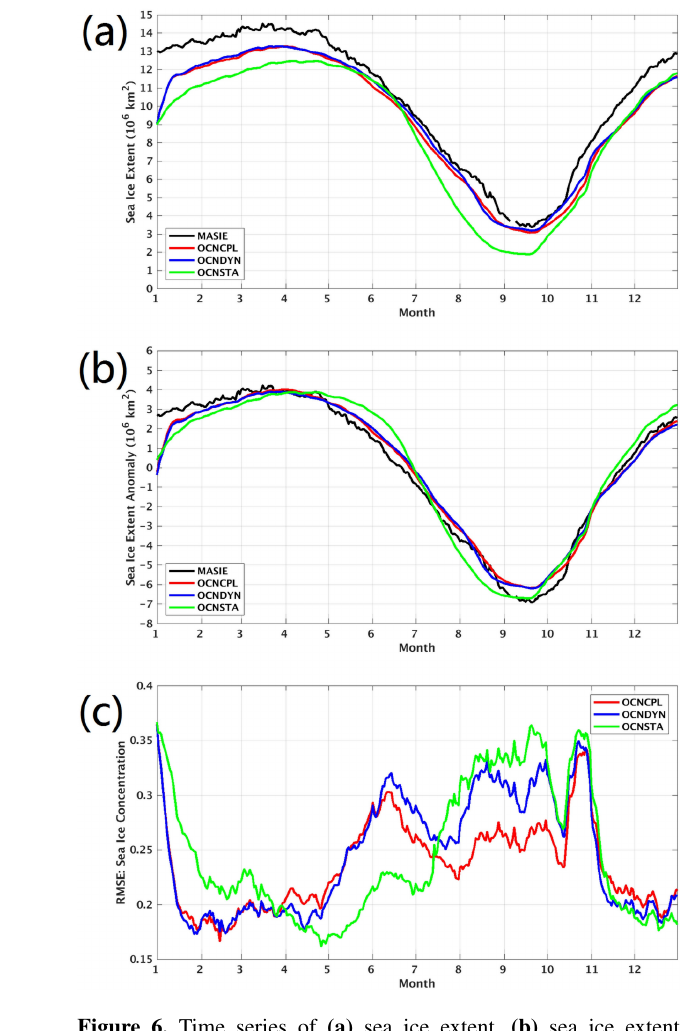
Figure 6. Time series of (a) sea ice extent, (b) sea ice extent anomaly and (c) root mean square error (RMSE) of modeled sea ice concentration with respect to the OSISAF observation in 2012. The black, red, green and blue lines in (a) denote sea ice extent of the MASIE observation, the OCNCPL run, the OCNSTA run and the OCNDYN run, respectively. The black, red, green and blue lines in (b) denote sea ice extent anomaly of the MASIE observa- tion, the OCNCPL run, the OCNSTA run and the OCNDYN run, respectively. The red, green and blue lines in (c) denote the sea ice concentration RMSE of the OCNCPL run, the OCNSTA run and the OCNDYN run, respectively. MASIE: Multisensor Analyzed Sea Ice Extent; OSISAF: Ocean and Sea Ice Satellite Application Facility.